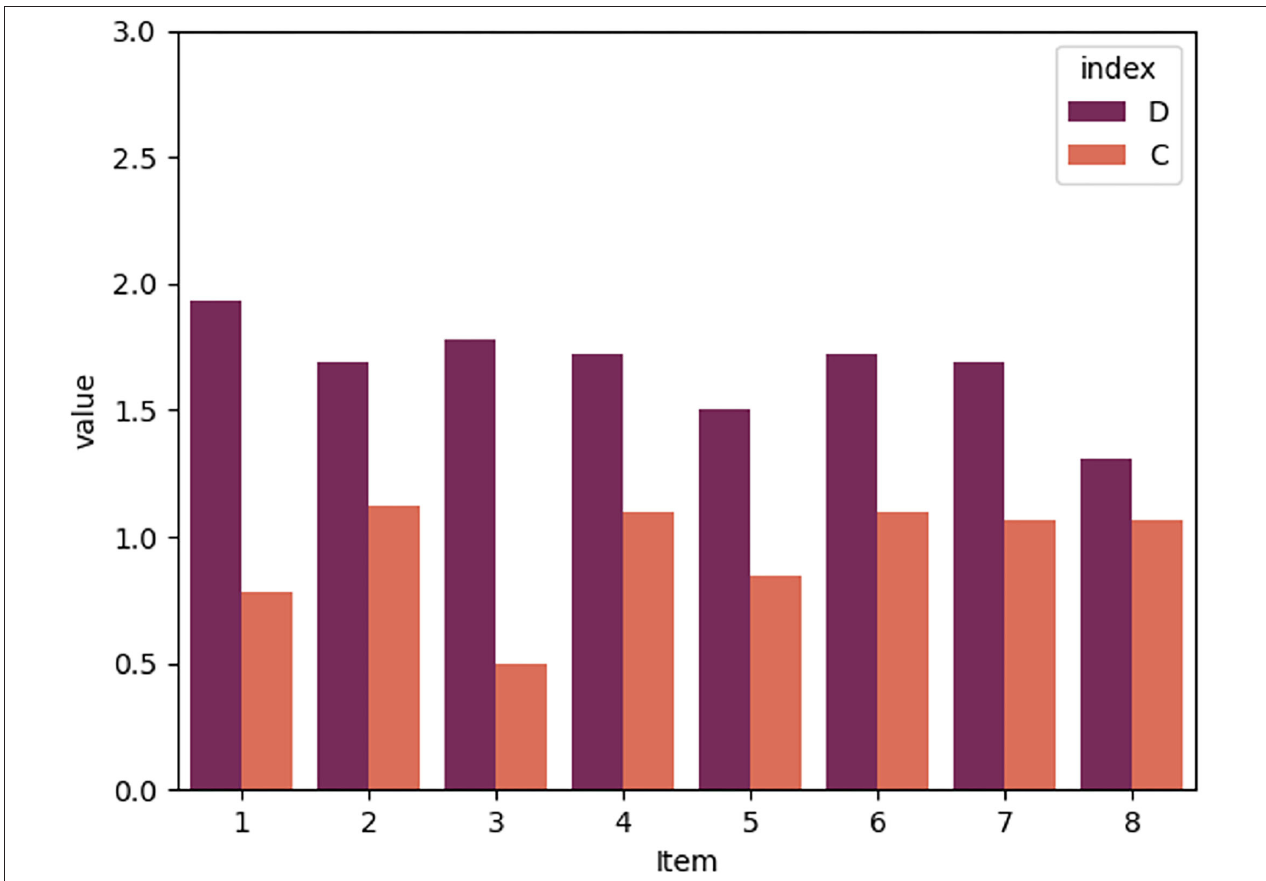
FIGURE 3 | The User Experience Questionnaire (UEQ)-S results. D, dashboard; C, resource comparison. Items: (1) confusing/clear, (2) inefficient/efficient, (3) complicated/easy, (4) obstructive/supportive, (5) boring/exciting, (6) not interesting/interesting, (7) conventional/inventive, and (8) usual/leading edge. The UEQ-S scale starts from − 3, and the bottom part of the graph was cut off for visual clarity.